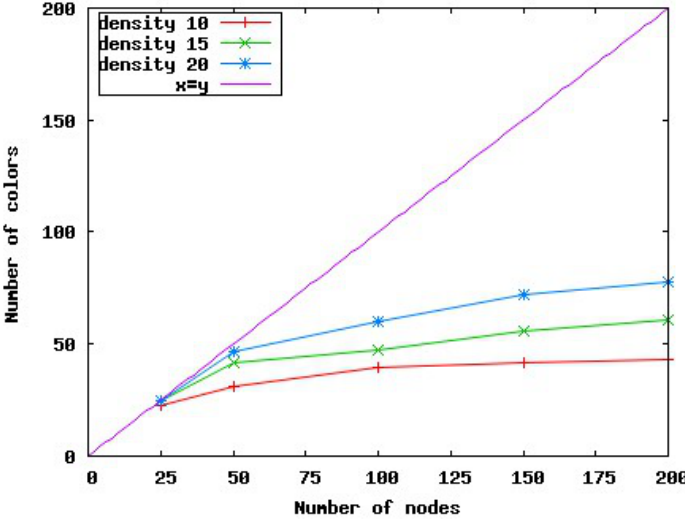
Figure 9. Number of colors used by SERENA for different network